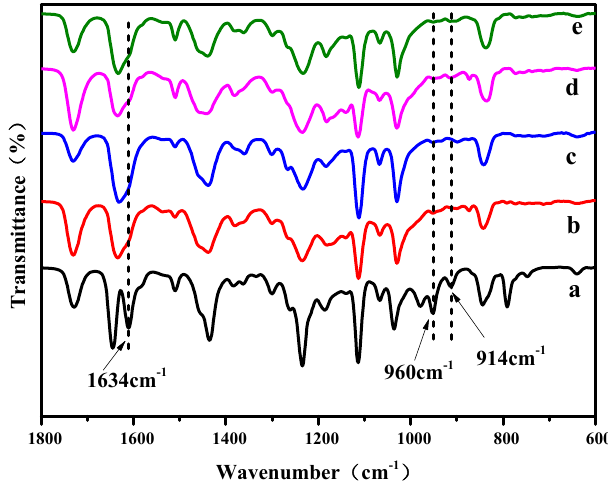
Figure 1. FT-IR spectra of the liquid resin and UV-cured hybrid resin with different content of UV-6110 (a, uncured hybrid resin; b,10% epoxy resin; c, 20% epoxy resin; d, 30% epoxy resin; e, 40% epoxy resin).